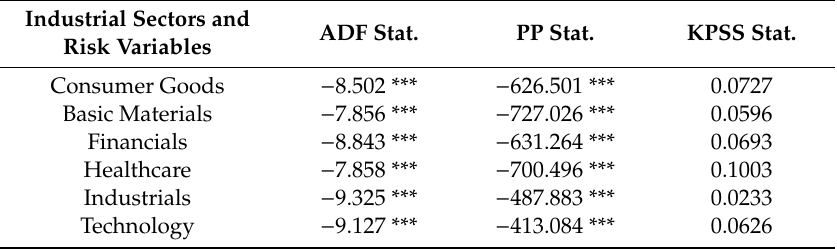
Table 3. Unit root tests of returns for the U.S. industrial sectors and risk